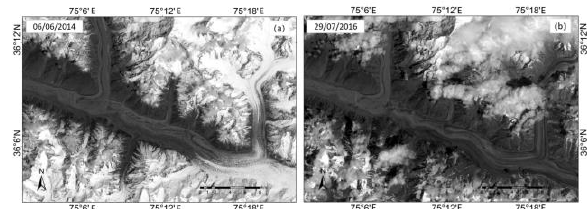
Figure 2 . Hispar Glacier, Karakoram mountain. (a) The beginning of surging behavior (June 6, 2014). (b) the Ending of the surging behavior (July 29, 2016). The image is Landsat ‐ 8 OLI (bands 8).